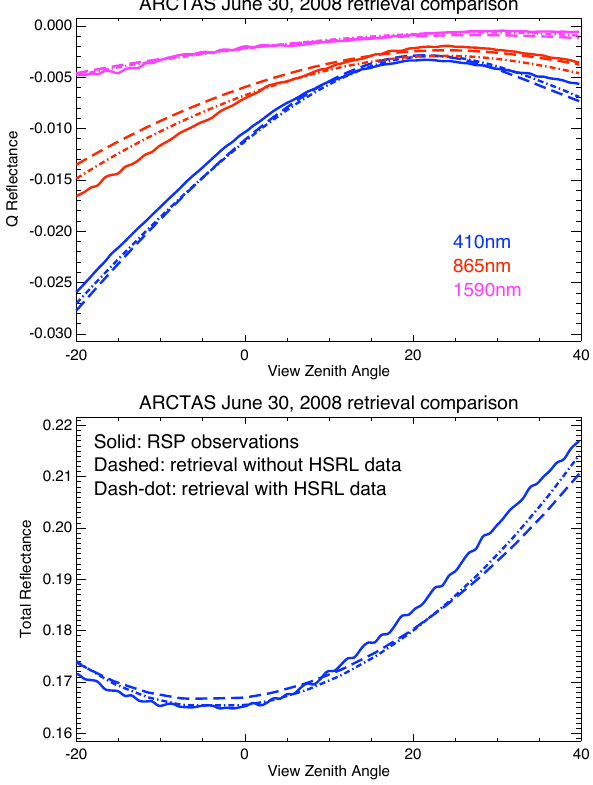
Fig. 5. These plots show results from a successful optimization utilizing HSRL data (dash-dot) compared to an unsuccessful opti- mization performed without HSRL data (dashed). This segment is the third from the left in Fig. 3, and RSP observed reflectances are plotted with solid lines. For clarity, the 470, 555 and 670nm bands are omitted, although they show a similar situation: optimization retrieved reflectances are quite similar for both